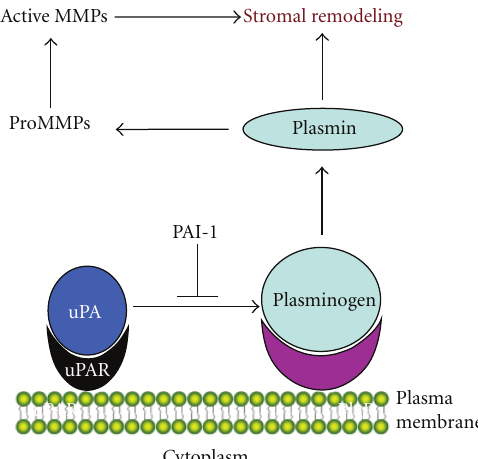
Figure 1: The plasmin/MMP axis in pericellular proteolytic con- trol. uPA, tethered to its receptor (uPAR), converts plasminogen receptor- (PlgR-) bound plasminogen to the broad-spectrum pro- tease plasmin that, in turn, activates several MMP family members. Collectively, plasmin and MMPs regulate the extent, duration, and locale of stromal